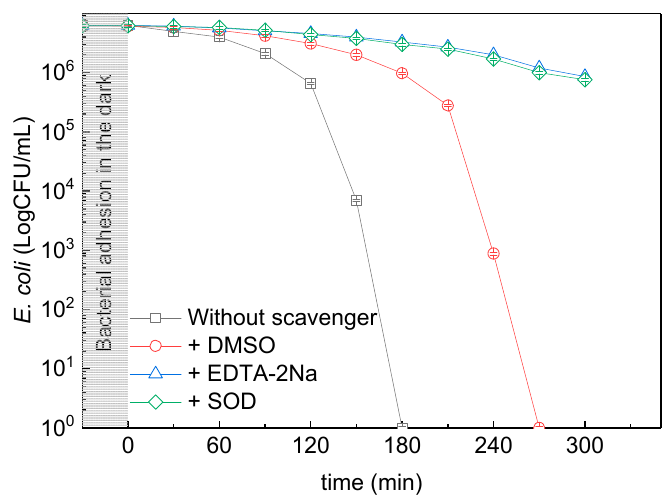
Figure 10. E. coli inactivation on AgNPs–TiO 2 ceramic tiles under low intensity solar simulated light (50 mW / cm 2 ) in the presence of ROS scavengers. DMSO, dimethylsulfoxide; EDTA, ethylenediamine-tetra-acetic acid sodium; SOD, superoxide dismutase.